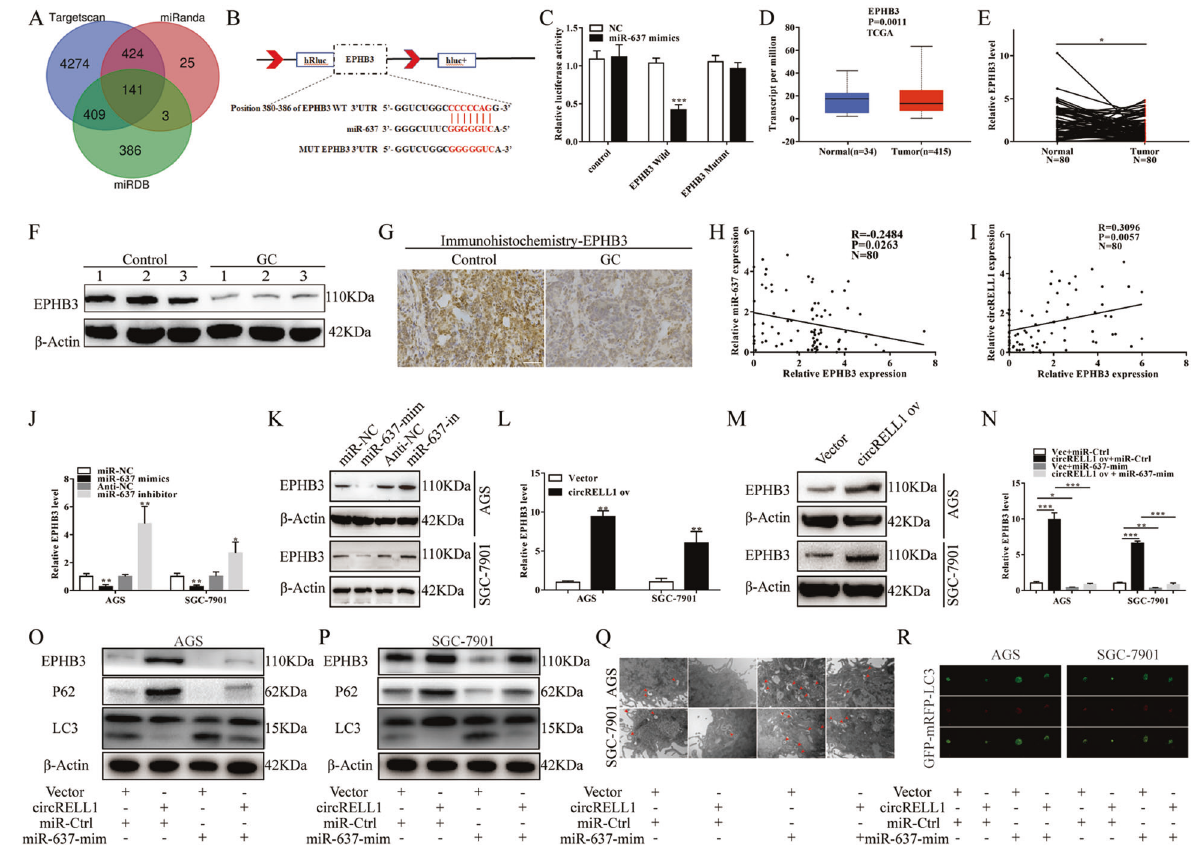
Fig. 8 EPHB3 as a miR-637 downstream target gene is regulated by circRELL1. A MiR-637 targets predicted using the TargetScan, miRDB, and miRanda. B The predicted binding sites between miR-637 and EPHB3. C Dual-luciferase assay was applied to investigate the direct binding between EPHB3 and miR-637 in HEK-293 cells. D Relative expression of EPHB3 GC tissues in TCGA database. E qRT-PCR analysis of EPHB3 levels in the paired GC and adjacent normal tissues. F , G IHC and WB assays were used to measure the EPHB3 protein levels in GC samples. H , I Correlation analysis of the relationship between circRELL1, miR-637, and EPHB3 in 80 GC tissues. J , K qRT-PCR and WB analyses were applied to detect the EPHB3 levels after co-transfection with miR-637 inhibitor, miR-637 mimics, or their controls. L , M qRT-PCR and WB analyses were applied to detect the EPHB3 levels after transfection with circRELL1-overexpressing plasmid or Vector. N – R Assessment of EPHB3 levels and autophagy activation after co-transfection with circRELL1-overexpressing plasmid, miR-637 mimics, or controls by qRT-PCR, WB analyses, TEM, and confocal microscopy. Results are presented as mean ± SD of three independent experiments. * P < 0.05, ** P < 0.01, *** P <